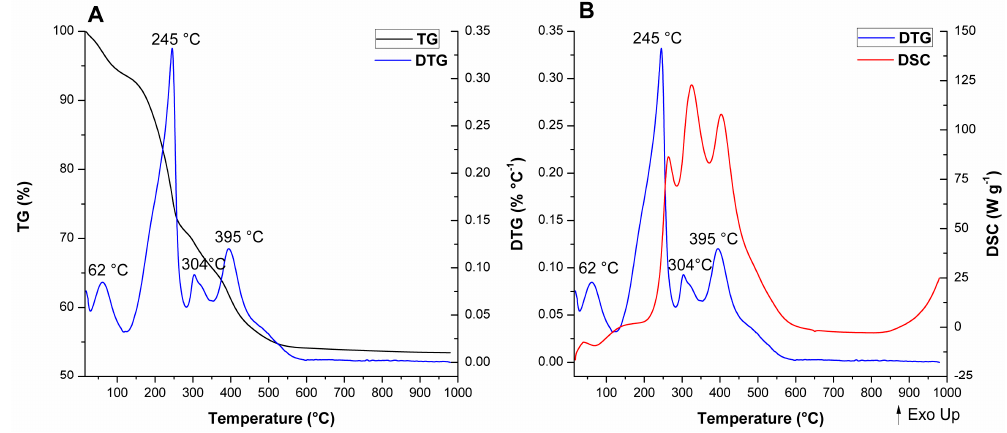
Figure 12. Thermal analysis obtained under synthetic air for A-Ce-MCM-Cl: TG and DTG curves ( A ); DTG and DSC curves ( B ). The temperatures indicated refers to DTG maximums of observable peaks.